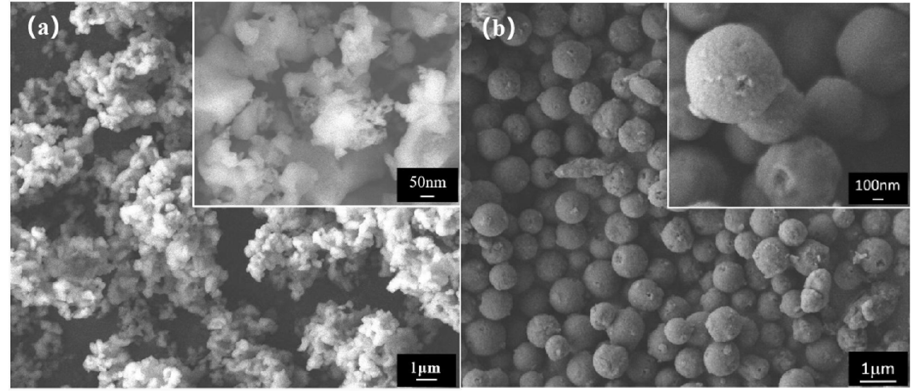
Figure 1. SEM images of ( a ) for ami-g-MS and ( b ) for ami-MSN.